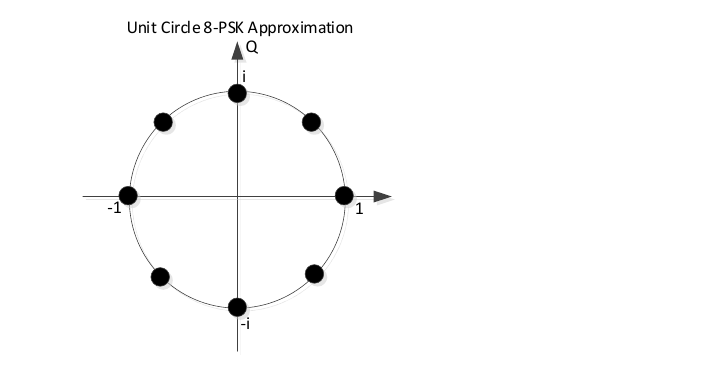
Figure 11. 8-PSK approximation of the unit-circle FZC baseband symbols.